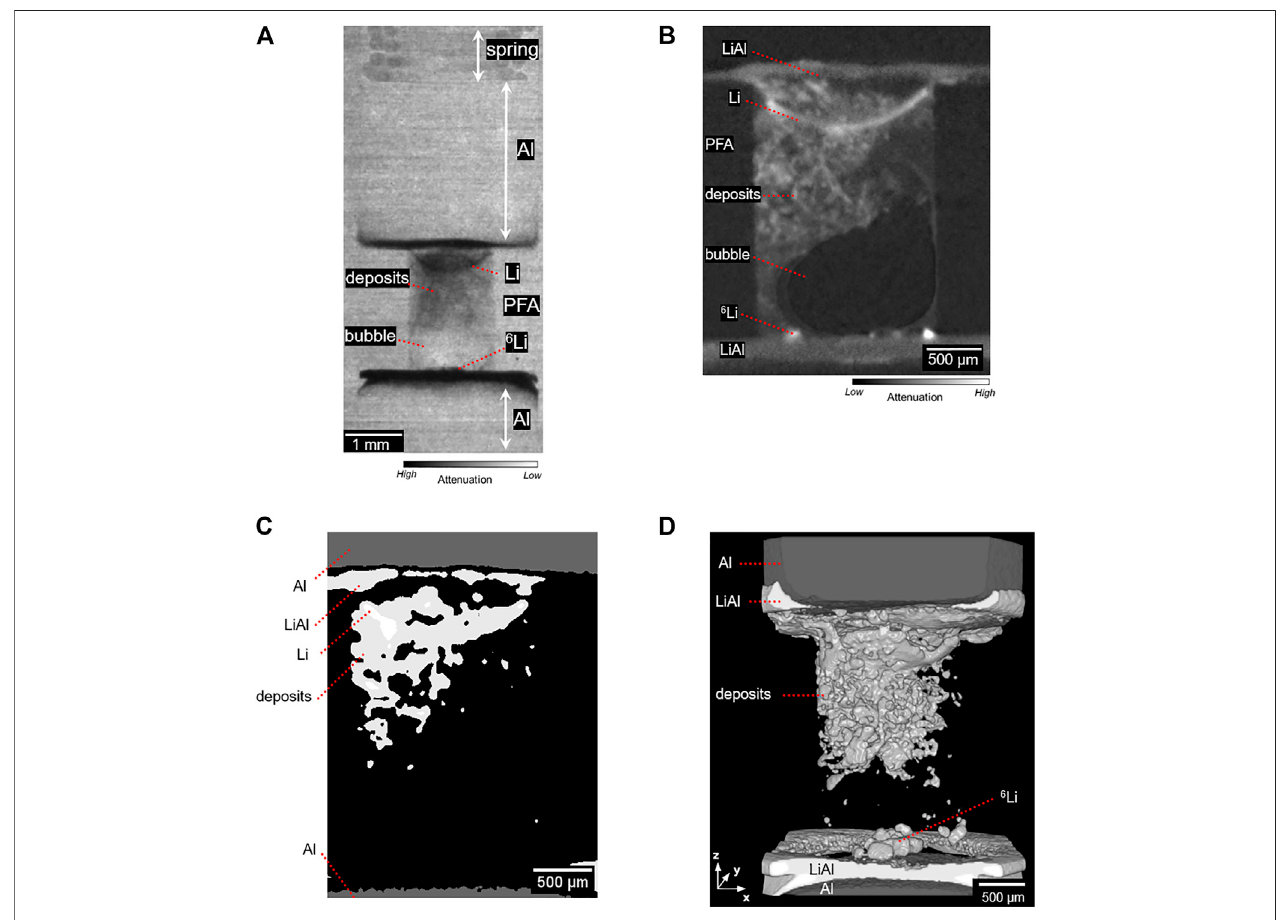
FIGURE 4 | Typical image of the cycled 6 Li – Li Cell_ A recorded at room temperature from (A) neutron radiography (transmission contrasts), (B) slice of the reconstructed 3D stack obtained by neutron tomography (absorption contrasts), (C) result of the segmentation process performed on the slice shown in (B) , and (D) volume rendering from the segmentation